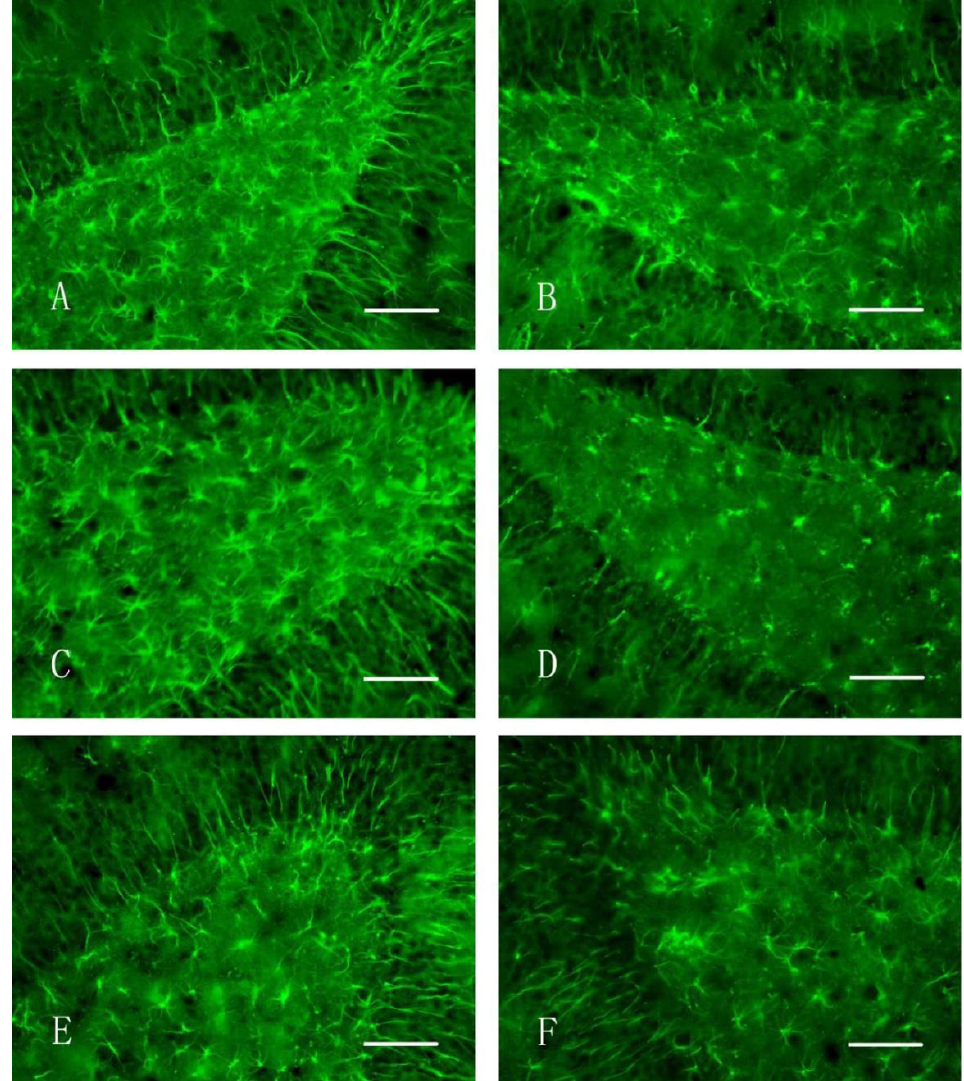
Figure 2. GFAP immunohistochemical staining of the hippocampus of rats (400×, Bar = 50 μm). ( A ) Damaged side, nano-MnO group; ( C ) damaged side, 6-OHDA group; ( D ) uninjured side, 6-OHDA group; ( E ) damaged side, saline group; and ( F ) uninjured side, saline